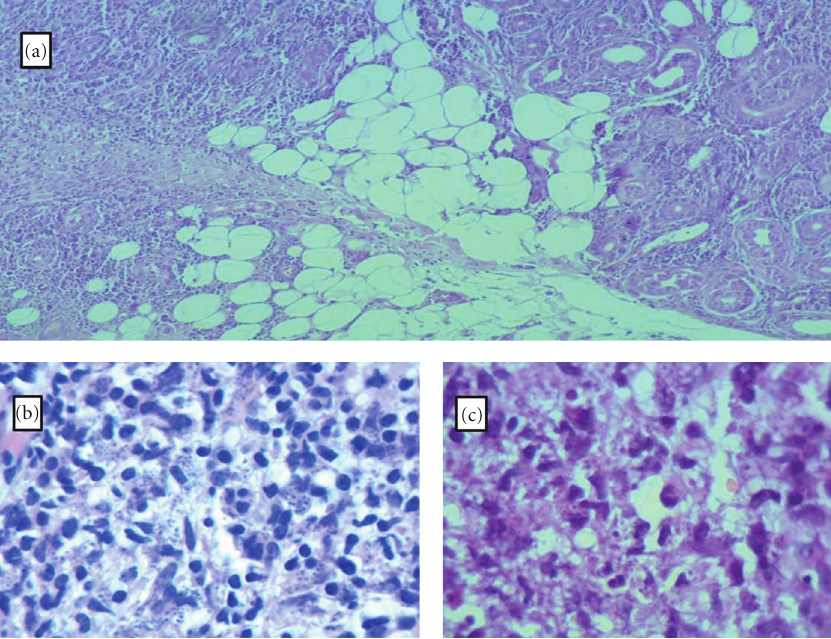
Figure 2: Microscopic view of septal and lobular panniculitis H&E × 400 (a), dermal foci of intra and extracellular LT bodies H&E × 1000 (b), non-metachromatic LT bodies Gimesa stain × 1000